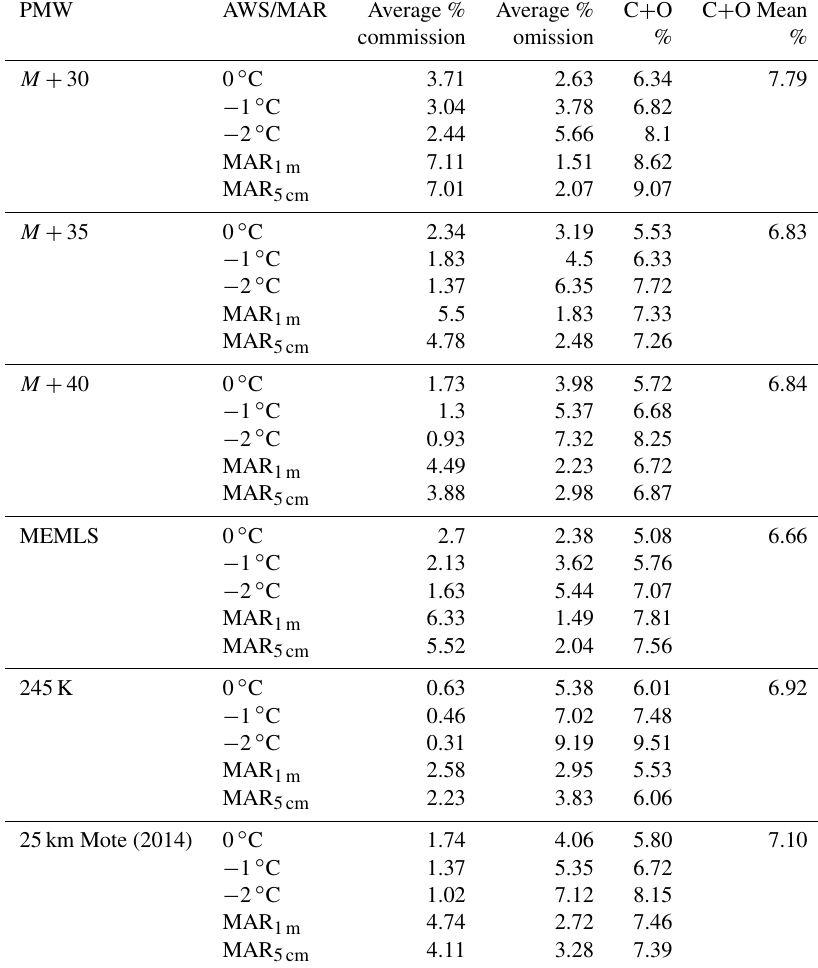
Table 5. Performance of the PMW melt detection algorithms studied with AWS and MAR data. Five thresholds are used to detect melt at a 3.125km resolution, and the Mote (2014) melting dataset is used as a 25km resolution comparison. For each case, three thresholds (0, − 1 and 2 ◦ C) are applied to the AWS data and two approaches (MAR 1m and MAR 5cm ) are applied to the MAR-simulated LWC to detect melt. The performance of the respective PMW melting products is computed in terms of commission and omission errors averaged for all of the AWS sites considered. C + O refers to the total error considering both commission and omission. The average of the C + O of each melting dataset (C + O Mean) is reported as a synthetic index of